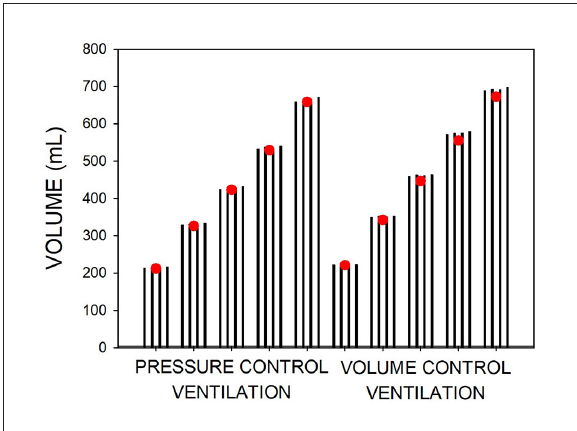
FIGURE6 Volume measured during different magnitudes of pressure-control and volume-control mechanical ventilation of a patient model. Volume was simultaneously measured with the low-cost and a reference pneumotachograph (red circles). Each set of four bars corresponds to the volumes measured by the low-cost pneumotachograph when using the different calibration parameters (K 1 , K 2 ) obtained by combining different resuscitation bag maneuvers (Table